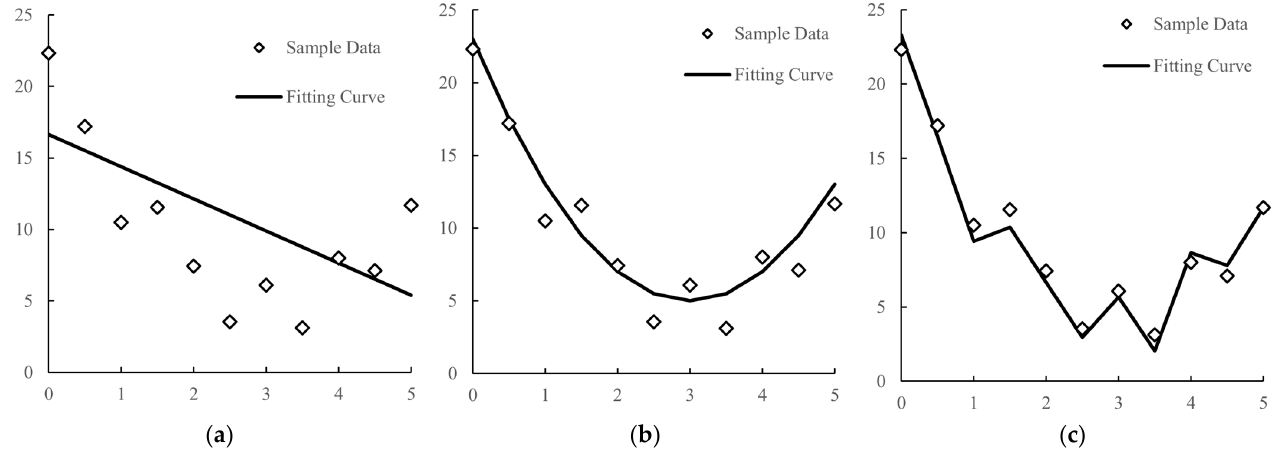
Figure 1. Data Fitting Performance: ( a ) Underfitting; ( b ) Just fitting; ( c ) Overfitting.